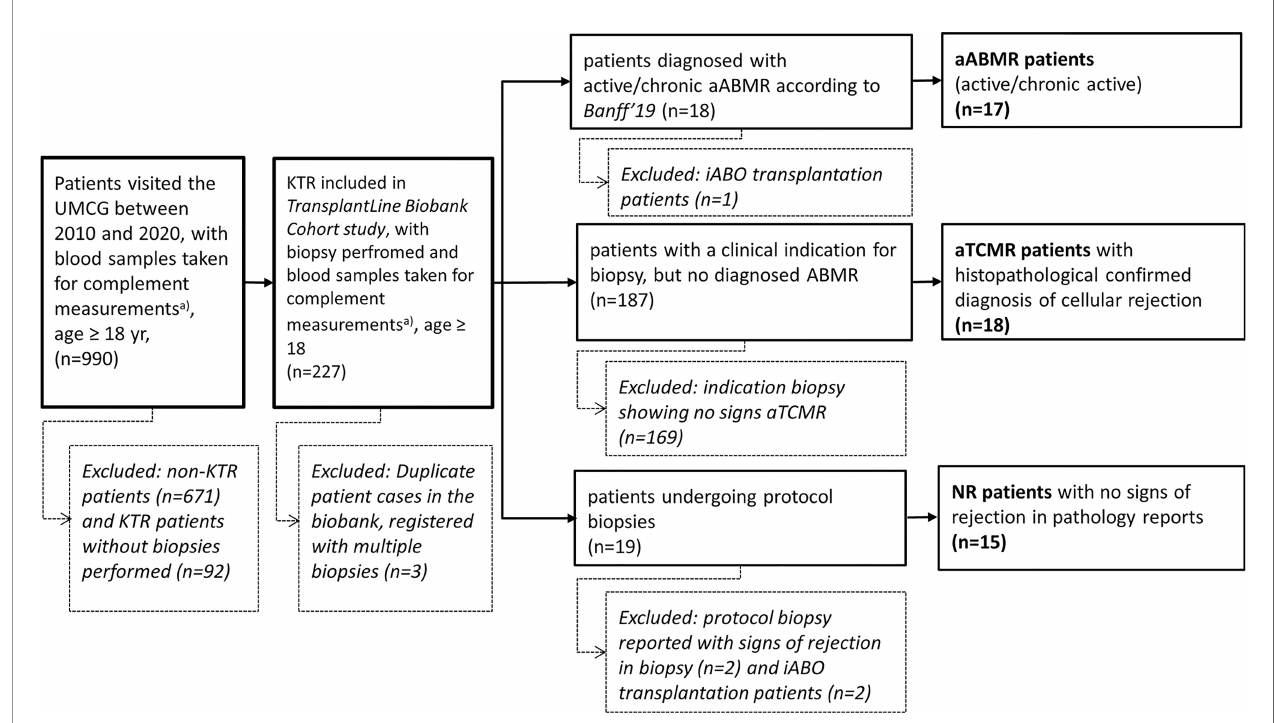
FIGURE 1 | Patient Selection with Inclusion and Exclusion Criteria. Flow chart representing selection of patients based on exclusion criteria. Total amount of patients excluded and included are depicted as (n). Exclusion of patients is presented in box with dotted lines. KTR, Kidney Transplant Recipients; UMCG, University Medical Center; yr, years; non-KTR, patients without a renal transplant; aABMR, active antibody-mediated rejection; iABO, blood group incompatible; aTCMR, acute T-cell mediated rejection; NR, non-rejection. a) with blood samples directly placed on